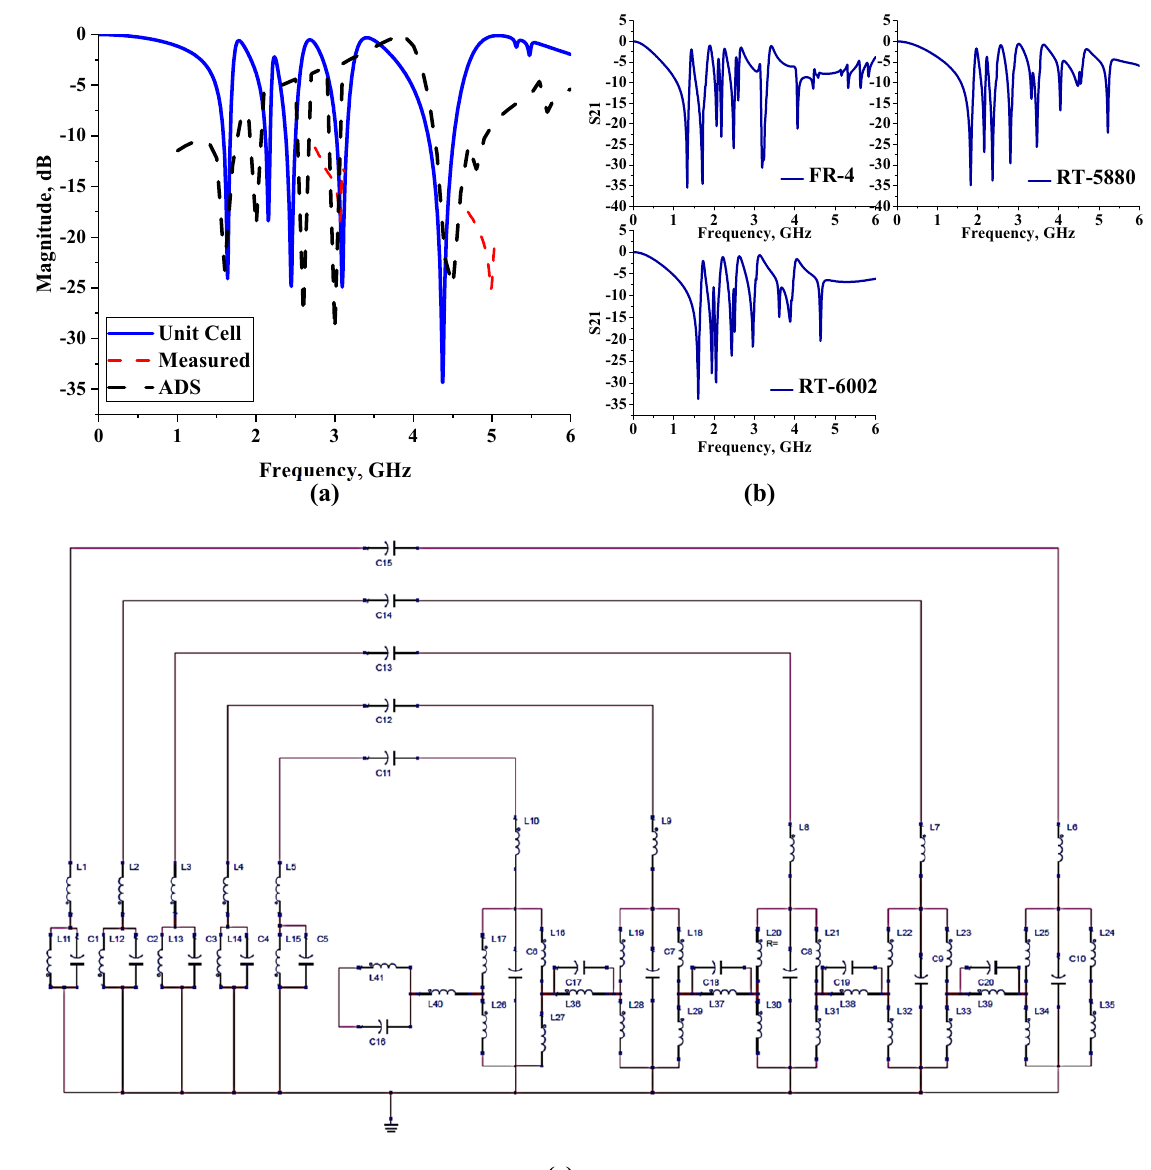
Figure 7. S21 results of: (a) Unit cell MSM design, (b) Several substrate materials analyses for proposed MSM design, ( c ) Equivalent